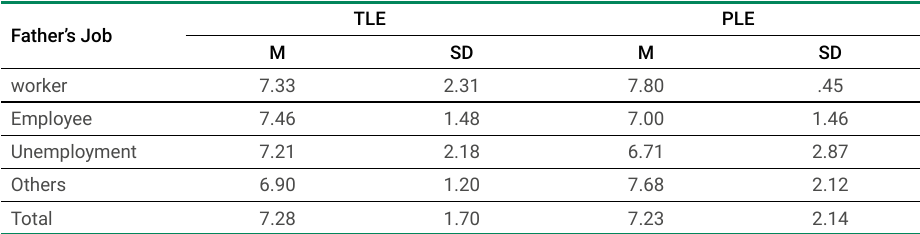
Table 3. The mean and standard deviation of the knowledge scores after intervention in terms of education type and Father’s Job TLE Father’s Job